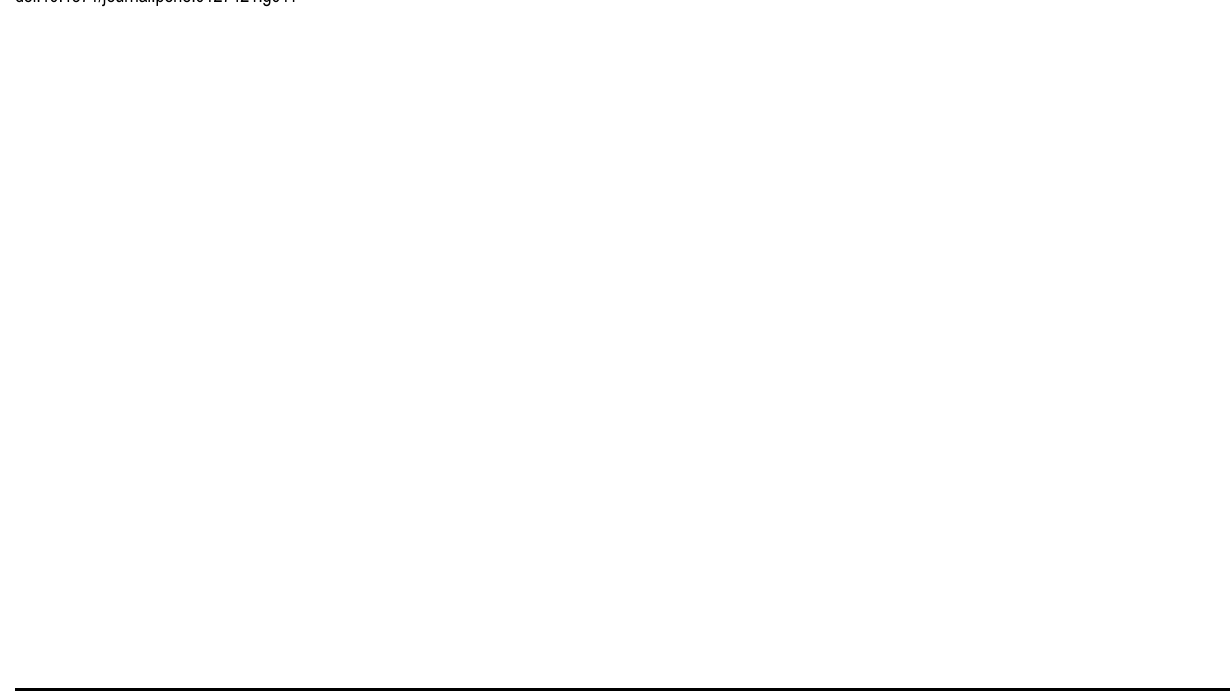
PLOS ONE | DOI:10.1371/journal.pone.0127421 May 26,